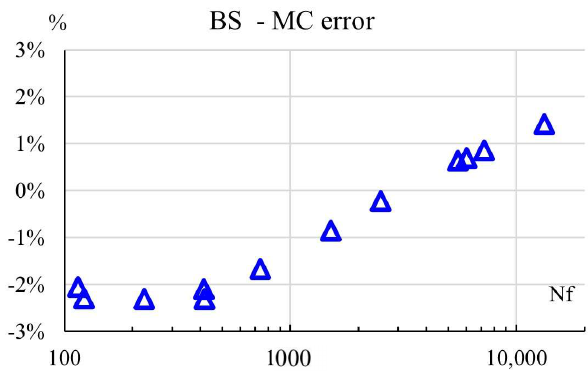
Figure 15. Error difference between the two Ti-specific rules.